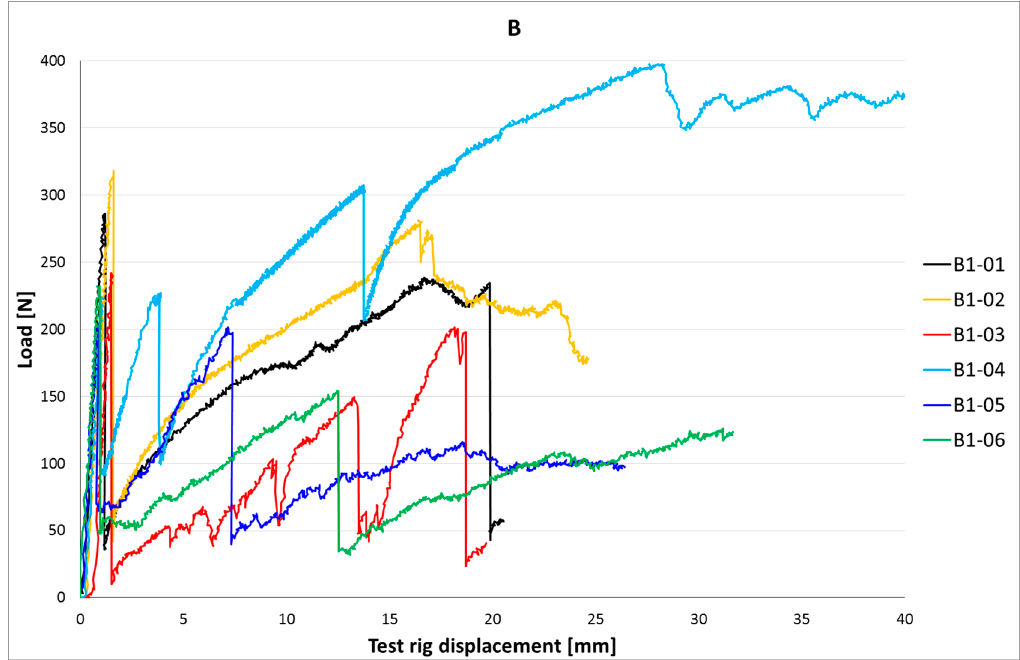
Figure 16. Load-displacement curves of printed beams with B-type cable.